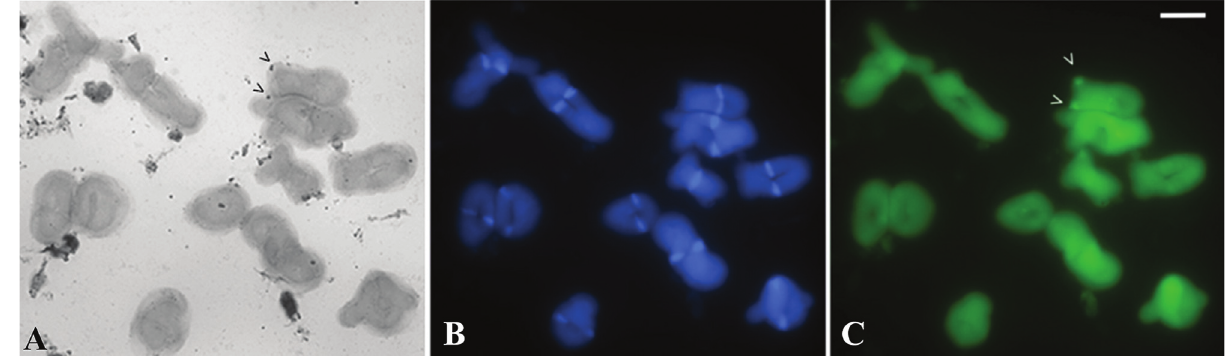
Figure 2 - Diakinesis: A) Ag-NOR, B) DAPI and C) CMA 3 staining patterns of Bolitoglossa paraensis . Arrowheads indicate the locations of NORs. Bar = 10 (cid:2) m.